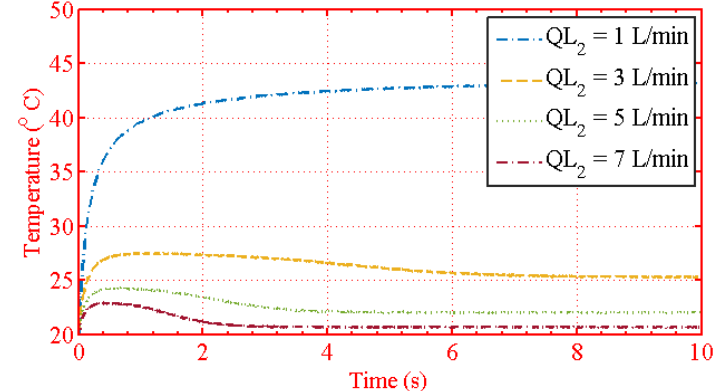
Figure 12. The output temperature in cold fluid with QL 1 = 1 L/min.